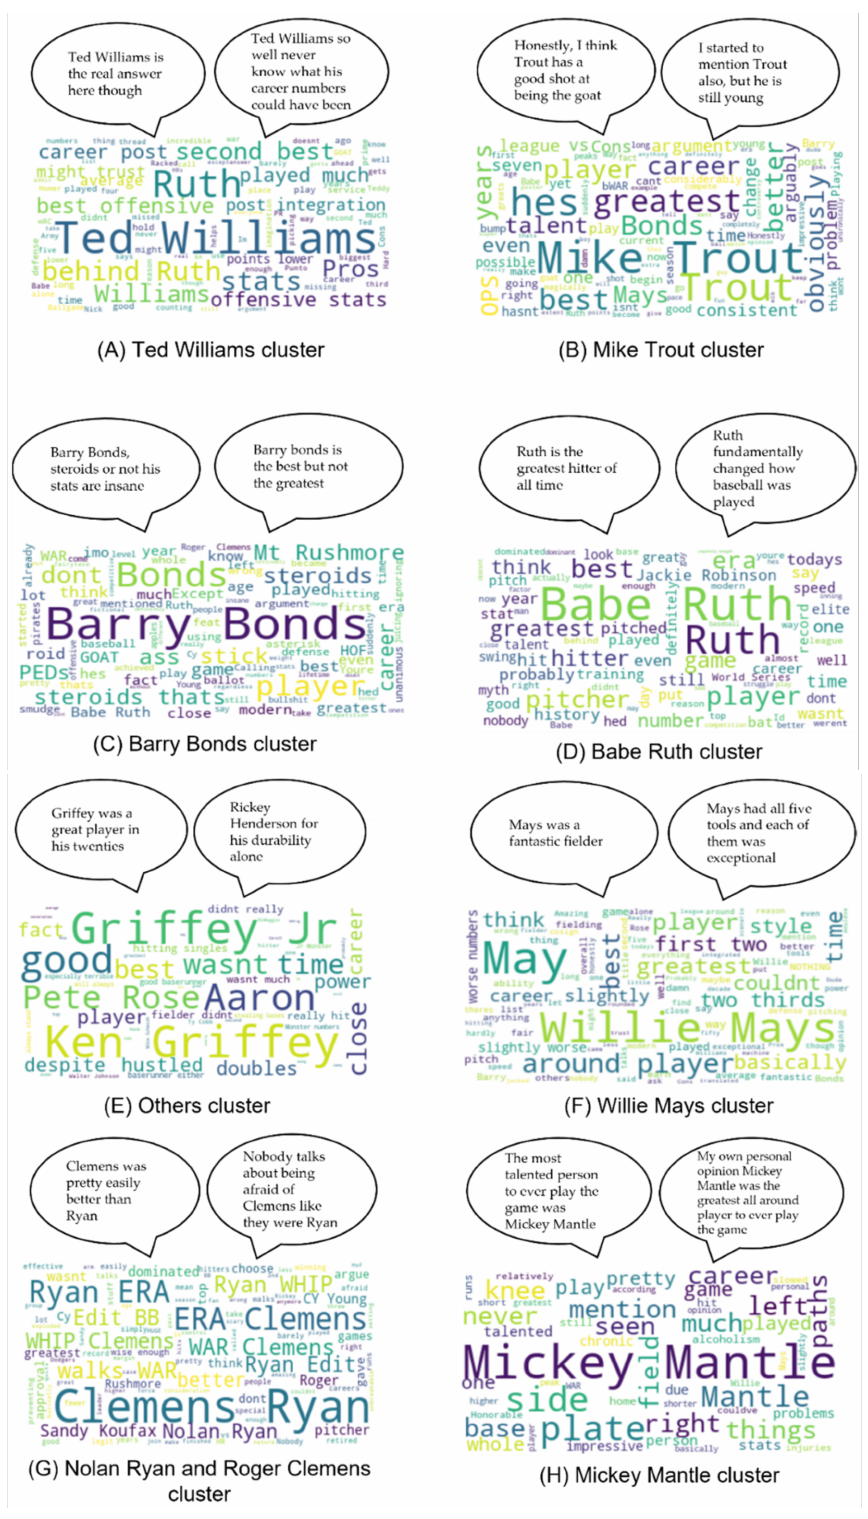
Figure 9. Word clouds with the clustering results of the baseball dataset. Validating this approach on the other dataset we had, the car brands dataset, wielded good results but not as good as the baseball dataset results, with 16 clusters and 0.59 silhouette score. The word clouds (Figures 10A–H and 11A–H) show some variety, but some clusters could have been better divided, since they refer to different